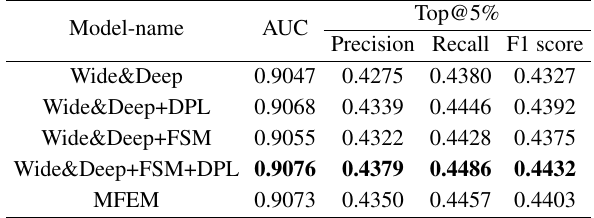
Table 5 Performance of transferring DPL to